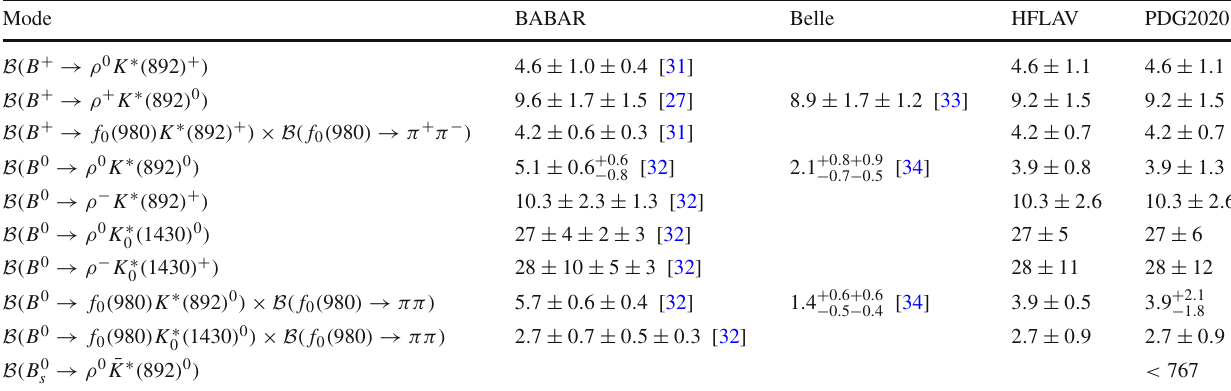
Table 1 Experimental branching fractions (in units of 10 − 6 ) of B → (ππ)( K π) decays [45,46] Mode BABAR